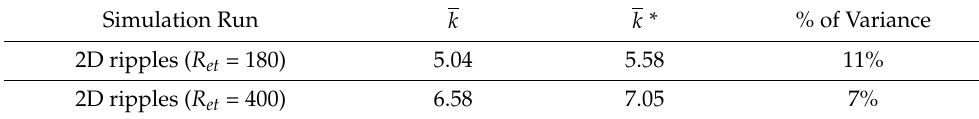
Table 2. Comparison of depth-averaged turbulent kinetic energy calculation. Simulation Run k k * % of Variance 2D ripples ( R et = 180) 5.04 5.58 11% 2D ripples ( R et = 400)